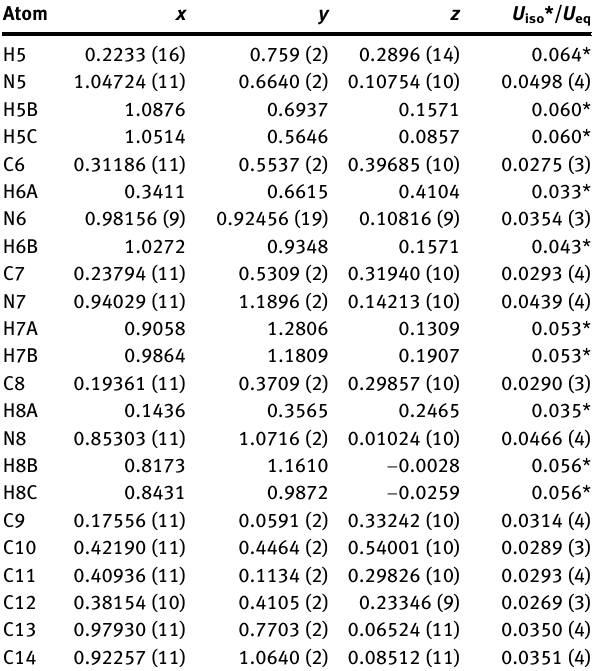
molar ratio of 1:1:2. After stirring for an hour, the solution was set aside to generate colorless block crystals of the title compound after about 2 weeks. Tetrapropylammonium hy- droxide was not present in the fi nal